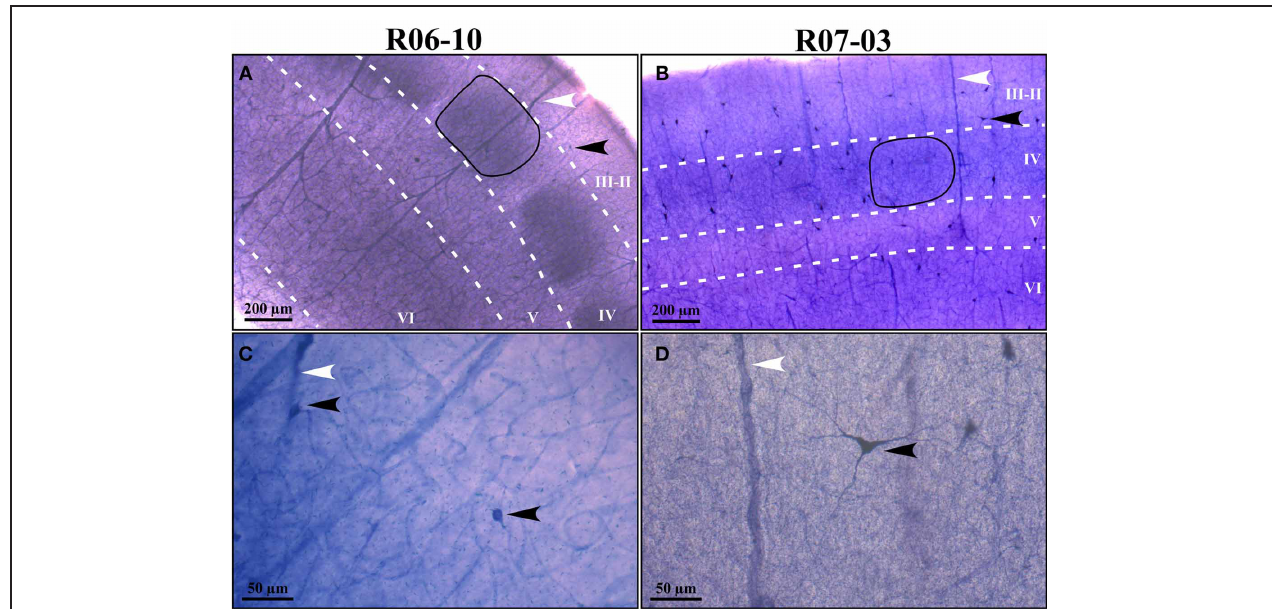
FIGURE 1 | NADPHd reactive neuropil and nitrergic (NADPHd type 1) neurons. (A,B) Low-magnification micrographs of cases R06-10 and R07-03, respectively, showing cortical layers (white dashed lines) and barrels in layer IV (the black continuous line depicts one example from each case). Layers IV and VI are more intensely labeled than layers II-III and V. It is not feasible by means of NAPDHd reactivity alone to identify the border between layers II and III. Intensely stained (type 1) NADPHd-reactive neurons can be identified (black arrowheads), and